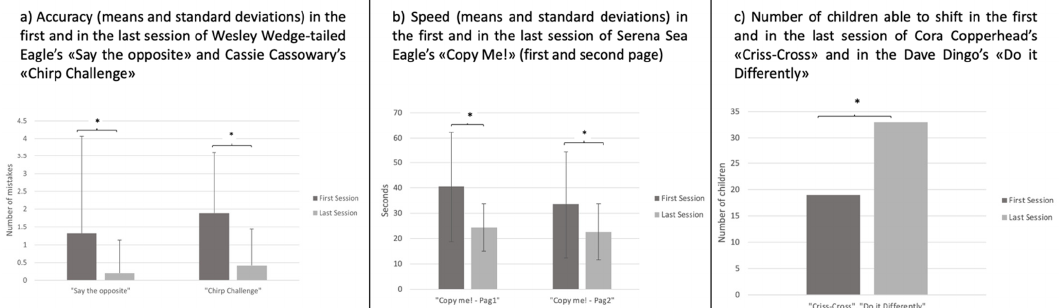
Figure 4. Graphics of the mean, standard deviations, and statistical significance ( t -test comparison) of the difference between initial and final scores in the main QQQ IT activities. * significant differences.